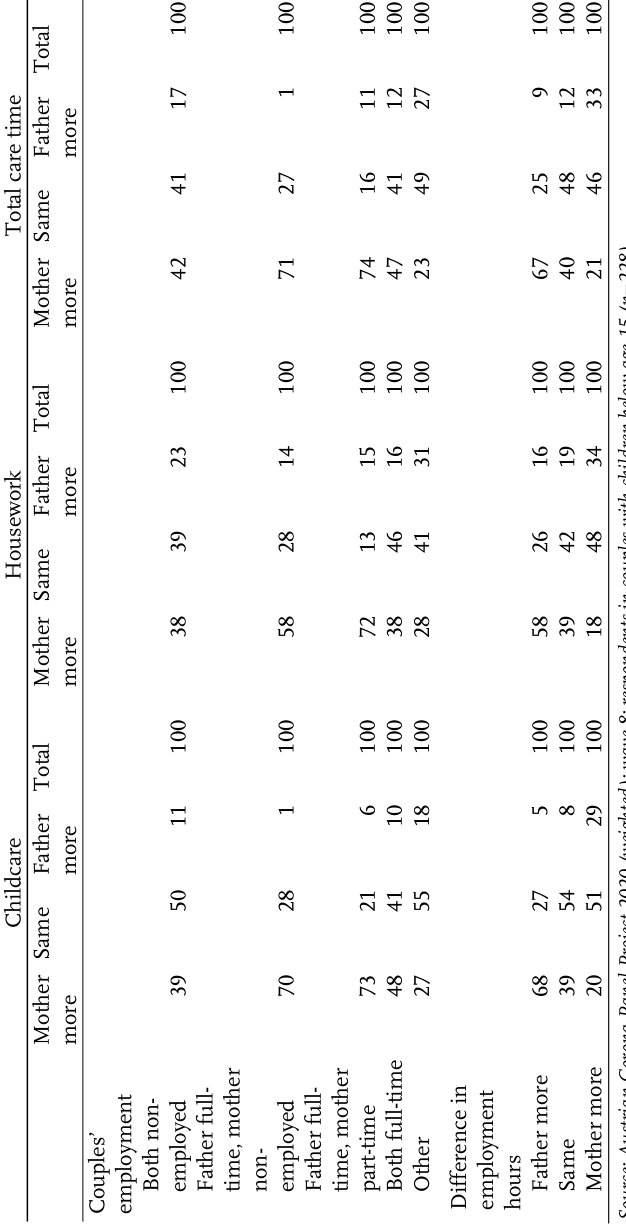
Table 5: Distribution of childcare, housework, and total care work in couples by